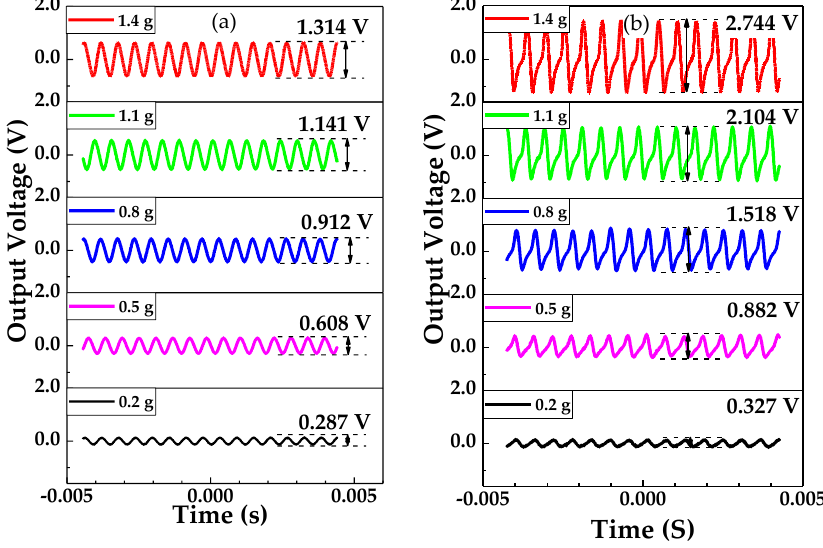
Figure 10. Output characteristics of the piezoelectric beam and PMA under the acceleration range from 0.2 g to 1.4 g: ( a ) output voltage curves of piezoelectric beam; ( b ) output voltage of PMAS.